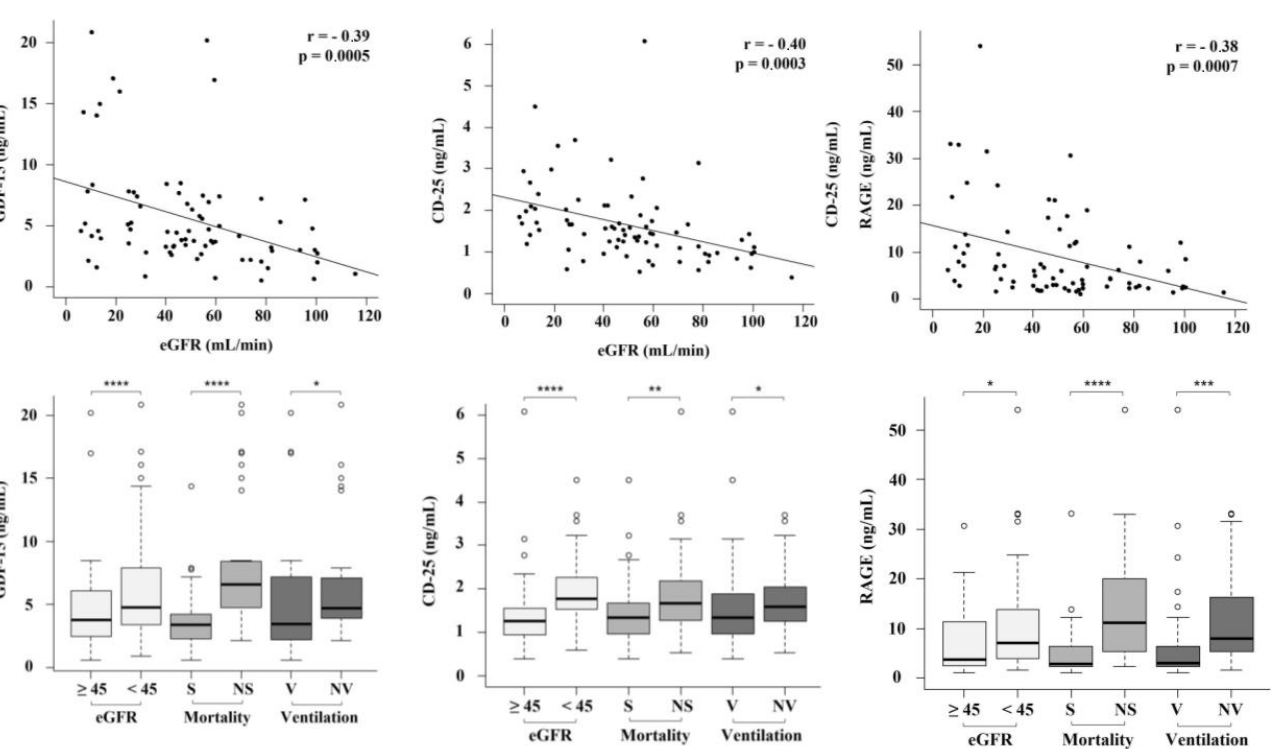
Figure 1. Association between GDF-15, CD-25 and RAGE with eGFR, ventilation and mortality. Abbreviations: eGFR, estimated glomerular filtration rate; GDF-15, growth and differentiation factor 15; RAGE, receptor for advanced glycation end products; S, survivors; NS, non survivors; NV,